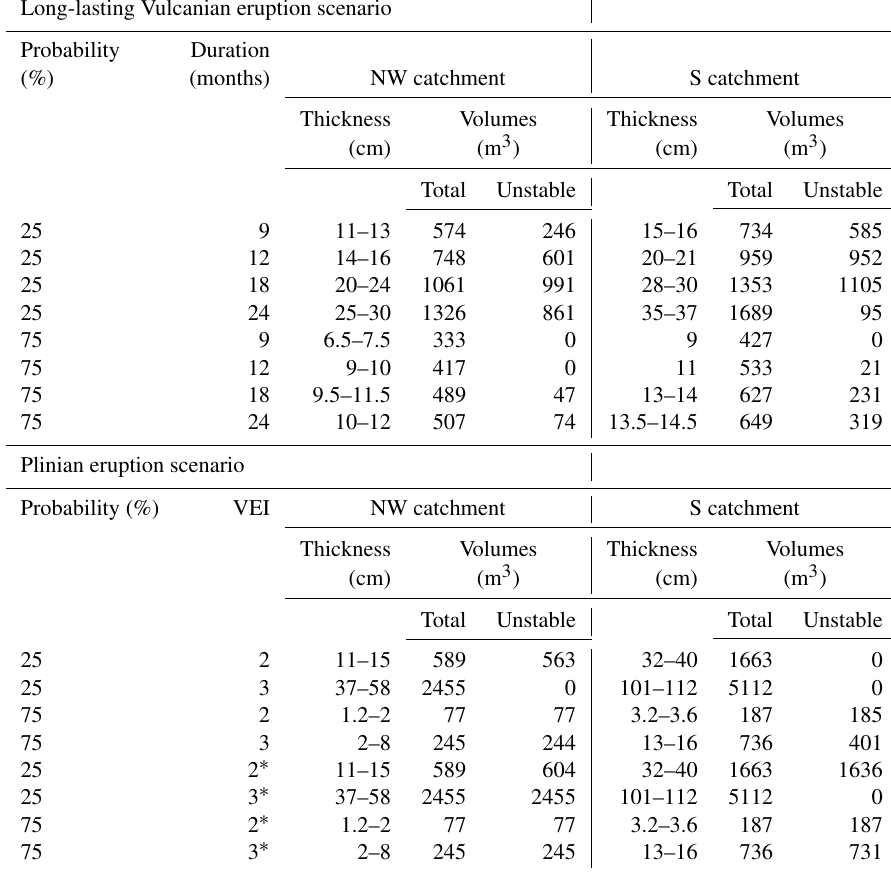
Table 5. Total and unstable volumes of primary tephra deposits for long-lasting Vulcanian and subplinian eruptions (VEI: K s from the literature; VEI ∗ : K s measured in the field) calculated with TRIGRS for the NW and S upper catchments. The NW and S upper catchments have the same area (4665m 2 ), with a mean slope of 43.5 and 40.1 ◦ , respectively. Rainfall intensity is 6.4mmh − 1 with a duration of 5h. Thickness: tephra fallout deposit thickness from probabilistic isopach maps considered in the